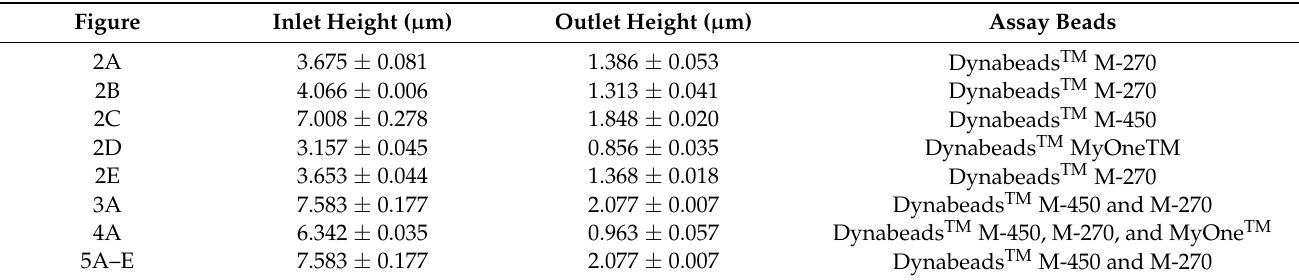
Table 1. Variable height channel parameters and assay beads used to generate the data in Figures 2–5. All channels had the same general height profile shown in Figure 1D between the inlet and outlet heights listed.